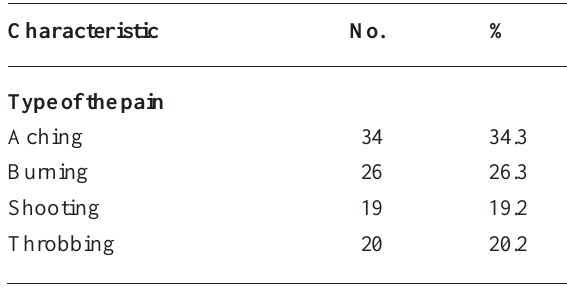
Table 1. Distribution of the